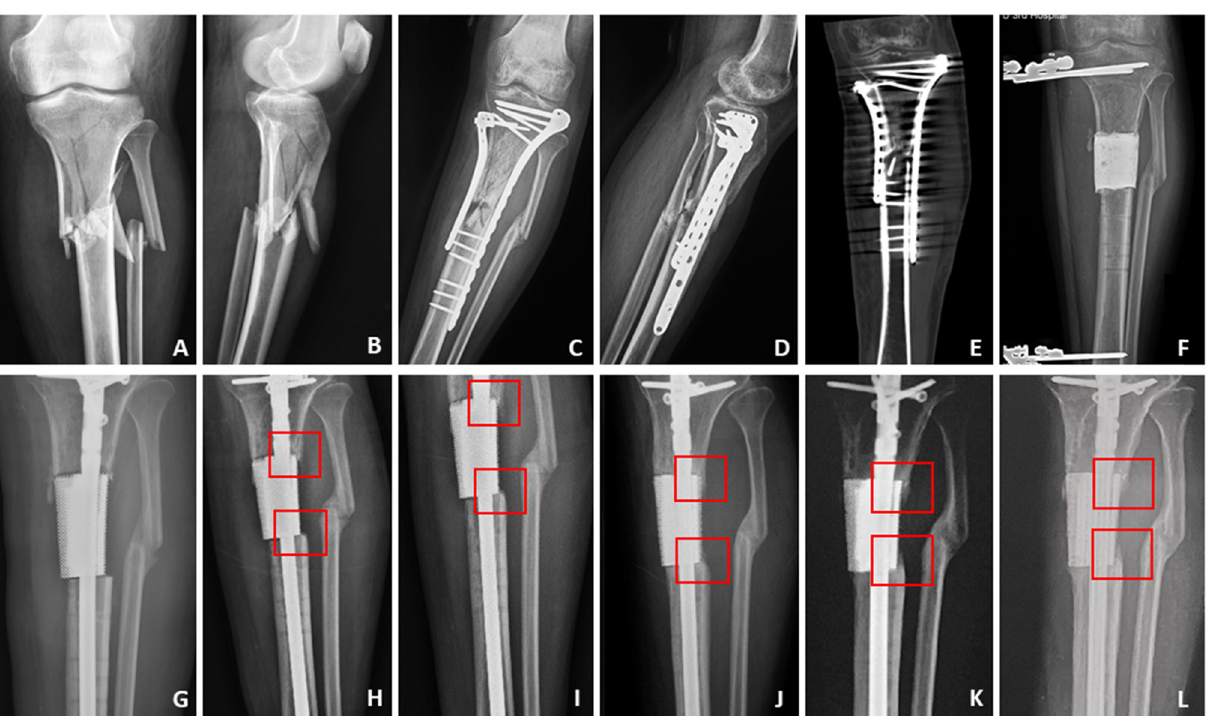
Fig. 3 The therapeutic process of the second typical case. A , B The initial X-ray displayed the patient suffered the tibial comminuted fracture; C – E the patient underwent the surgical treatment, and at 10 months after the initial surgery, X-ray and CT scan showed fracture nonunion and sequestrums; F we cleared the sequestrums and fi lled a PMMA spacer into the femoral defect with 6.3 cm length, and